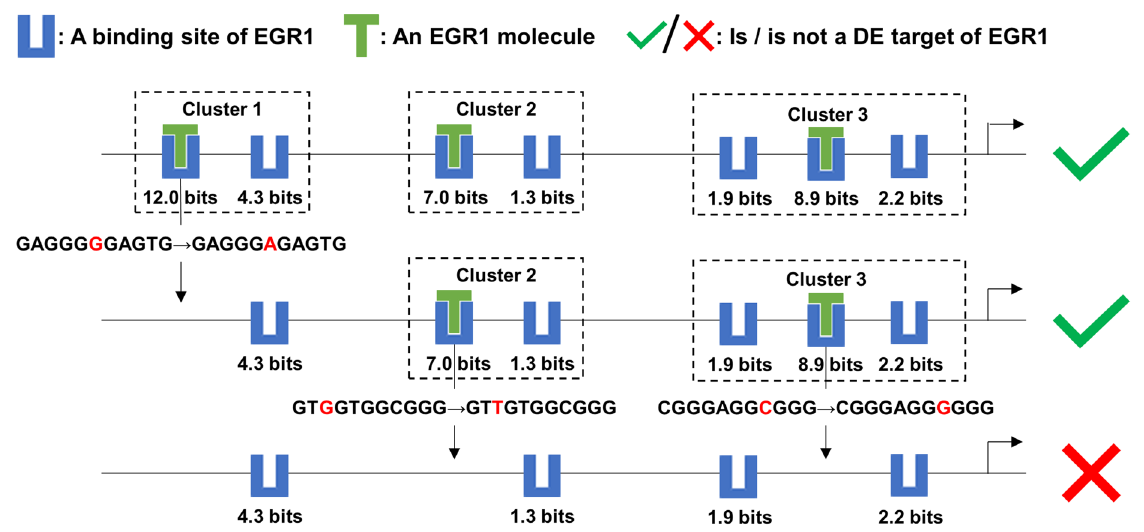
Figure 5. Mutation analyses on the target MCM7 of EGR1. This figure depicts the effect of a mutation in each EGR1 binding site cluster of the MCM7 promoter on the expression level of MCM7 , which is a target of the TF EGR1. The strongest binding site in each cluster were abolished by a single nucleotide variant. Upon loss of all three clusters, only weak binding sites remained and EGR1 was predicted to no longer be able to effectively regulate MCM7 expression. Multiple clusters in the promoters of TF targets confer robustness against mutations within individual binding sites that define these